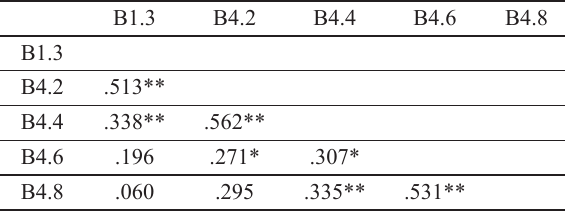
Table 4. Spearman’s rho correlation between variables associated with process